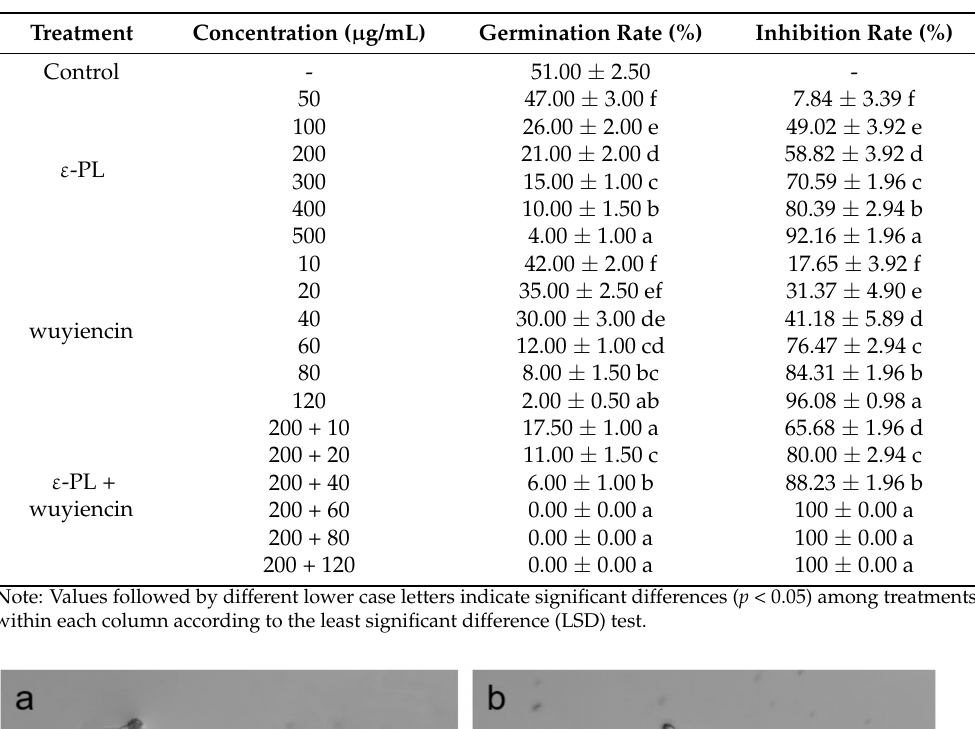
Table 3. Inhibitory effect of wuyiencin and ε -PL at different concentrations on conidial germination of Botrytis cinerea .